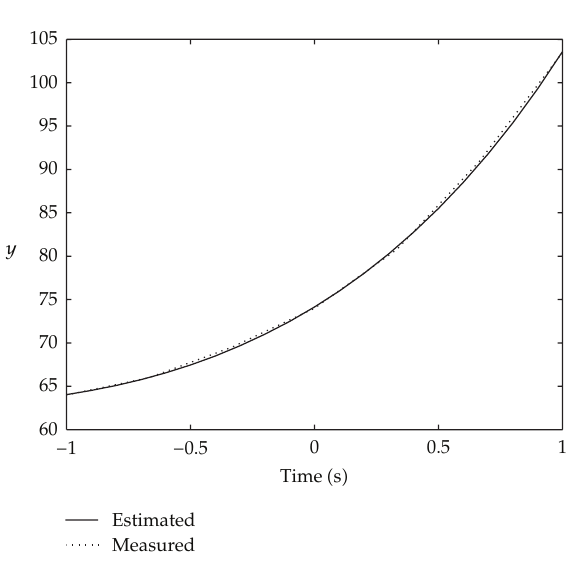
Figure 6: The plots of the estimated and measured data of y in Case 2 (cid:3) 53 iterations (cid:4)